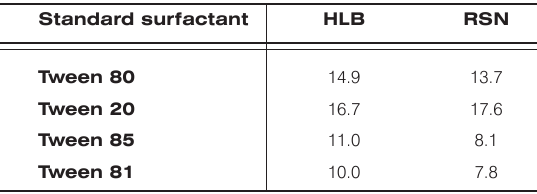
Table 1. Conversion data for determination of HLB standard